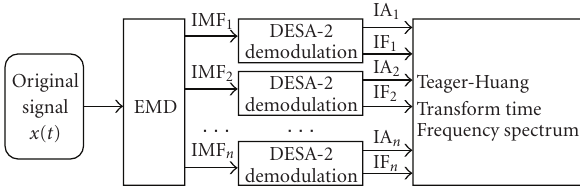
Figure 1: The flow chart of Teager-Huang Transform.